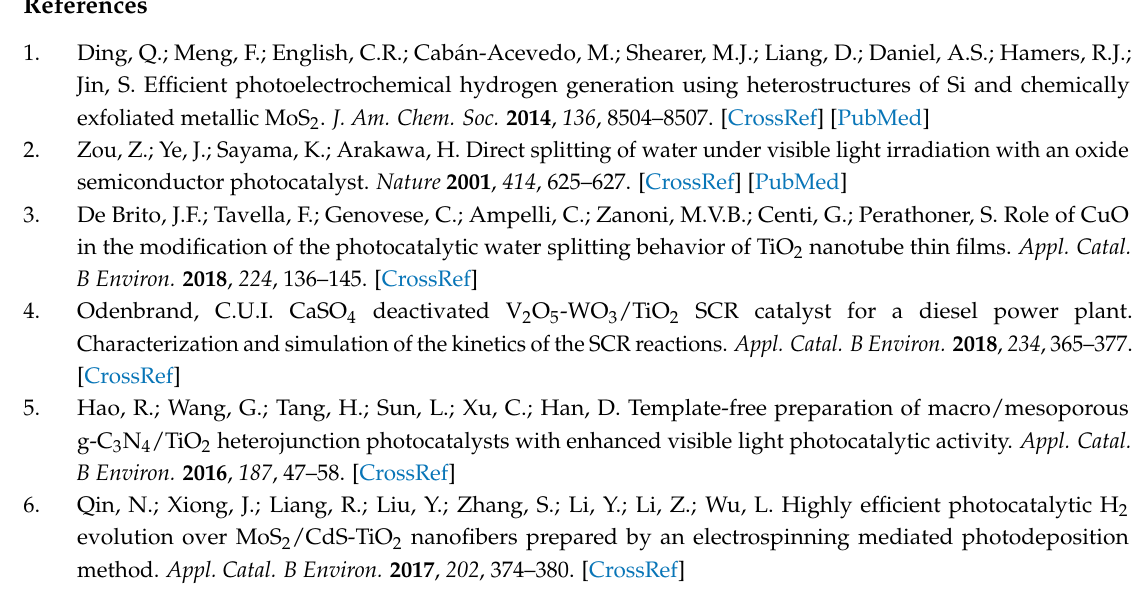
Figure S1: SEM images of (a) g-C 3 N 4 , (b) TiO 2 nanofibers, (c,d) CNT6 composite, Figure S2: XPS survey spectra of CNT6, Figure S3: The pore size distribution of TiO 2 nanofibers and CNT6 composite, Figure S4: Optical images of different products: (a) bare TiO 2 nanofibers, (b) g-C 3 N 4 , (c) CNT2, (d) CNT4, (e) CNT6, and (f) CNT7, Figure S5: The curves of (h ν · F(R)) 1/2 versus h ν originated from the diffuse reflectance spectra, Figure S6: PL spectra of commercial TiO 2 P25 and the enlarged view of partial curves in Figure 6, Figure S7: (a) Photocatalytic degradation RhB curves under visible light irradiation over different samples, (b) kinetic curves of degradation RhB over different as-prepared